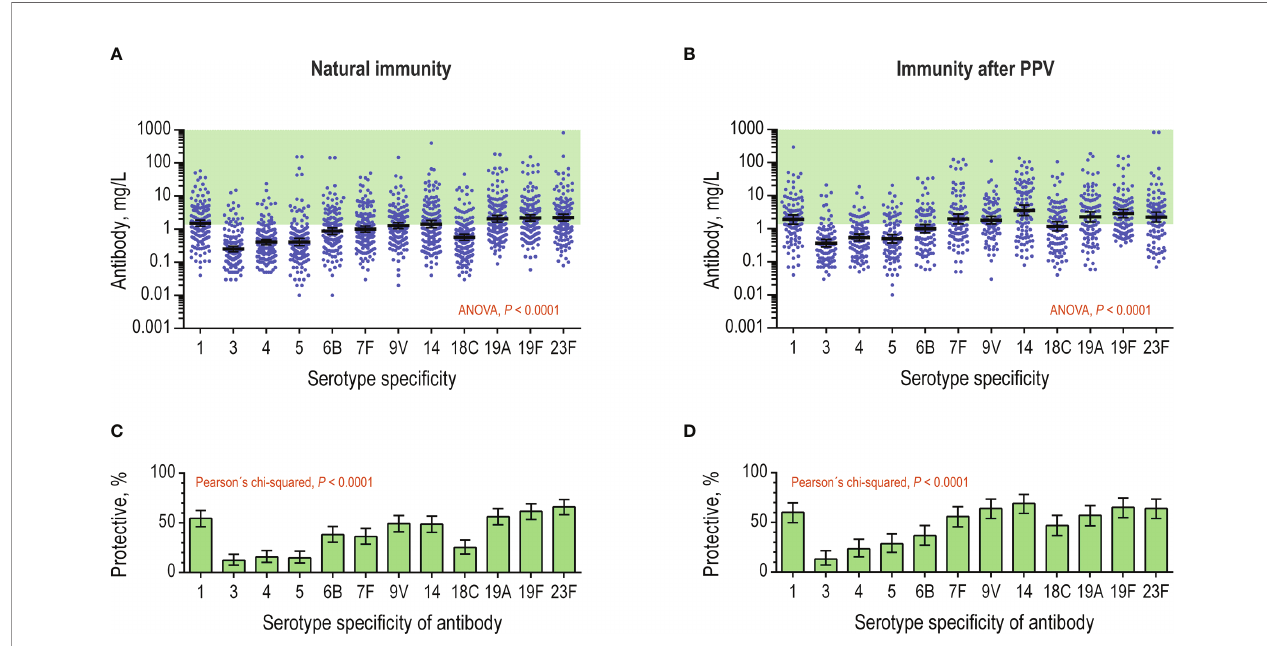
FIGURE 4 | Serotype-speci fi c antibody levels in the patient serum samples. The concentrations (mg/L) of 12 different antibodies were determined in serum samples by a multiplex, bead-based assay. (A) The natural immunity of the patients ( n = 154) displayed for each of the antibodies as continuous variables. The green area indicates concentrations of at least 1.3 mg/L, which is considered as ‘ protective ’ under AAAAI guidelines. Error bars are geometrical means with 95% con fi dence intervals. The antibodies were tested for different levels using repeated-measures ANOVA. (B) Data from previous panel showing the proportion of patients with antibody levels of at least 1.3 mg/L (i.e., ‘ protective level ’ ) for each speci fi c antibody. (C) As in the panel A, but for levels measured in serum samples collected after PPV vaccination ( n = 98). (D) Data from previous panel, showing the proportion of patients with antibody levels of at least 1.3 mg/L for each speci fi c